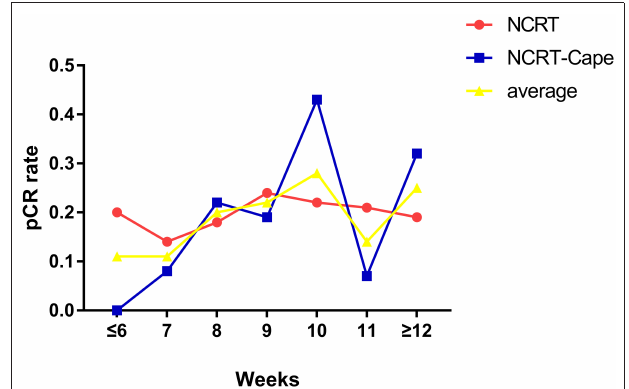
FIGURE 2 | The relationship between time intervals and pCR rates. NCRT, neoadjuvant chemoradiotherapy; NCRT-Cape, neoadjuvant chemoradiotherapy, and additional capecitabine chemotherapy.